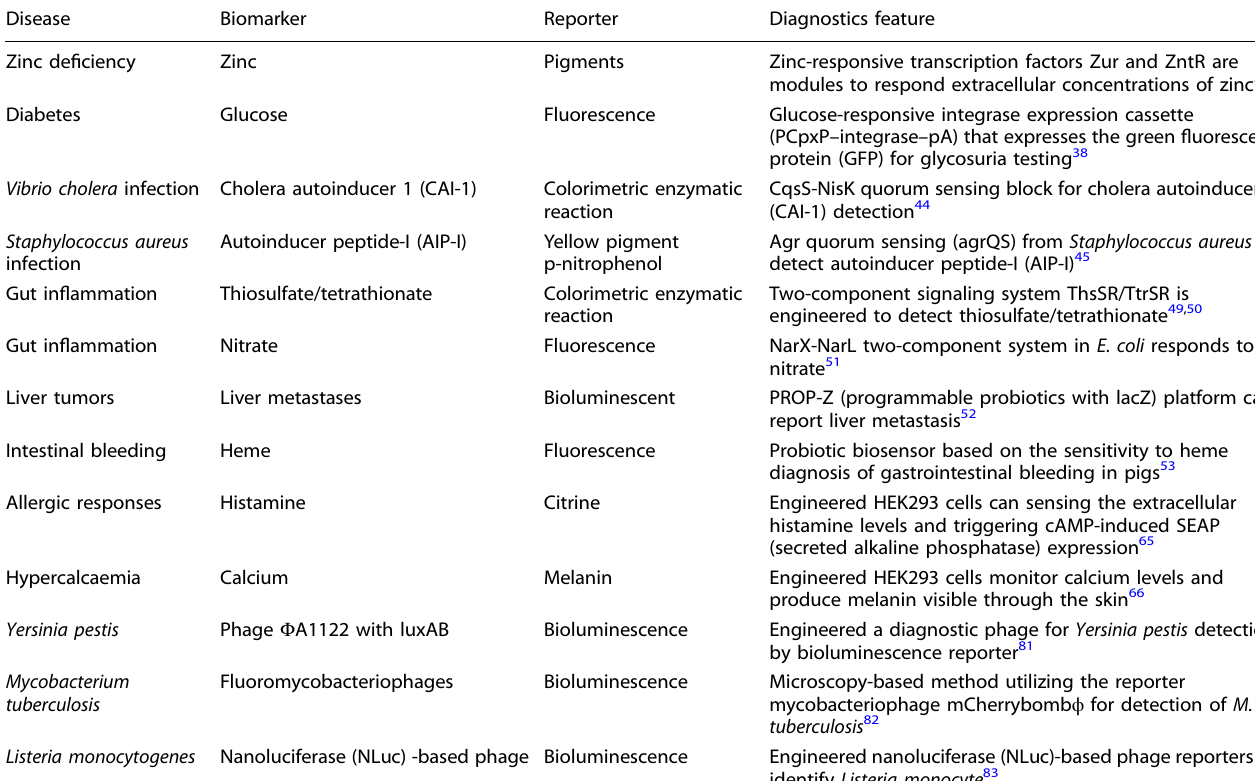
Table 1. Advances in engineering cells for disease diagnosis